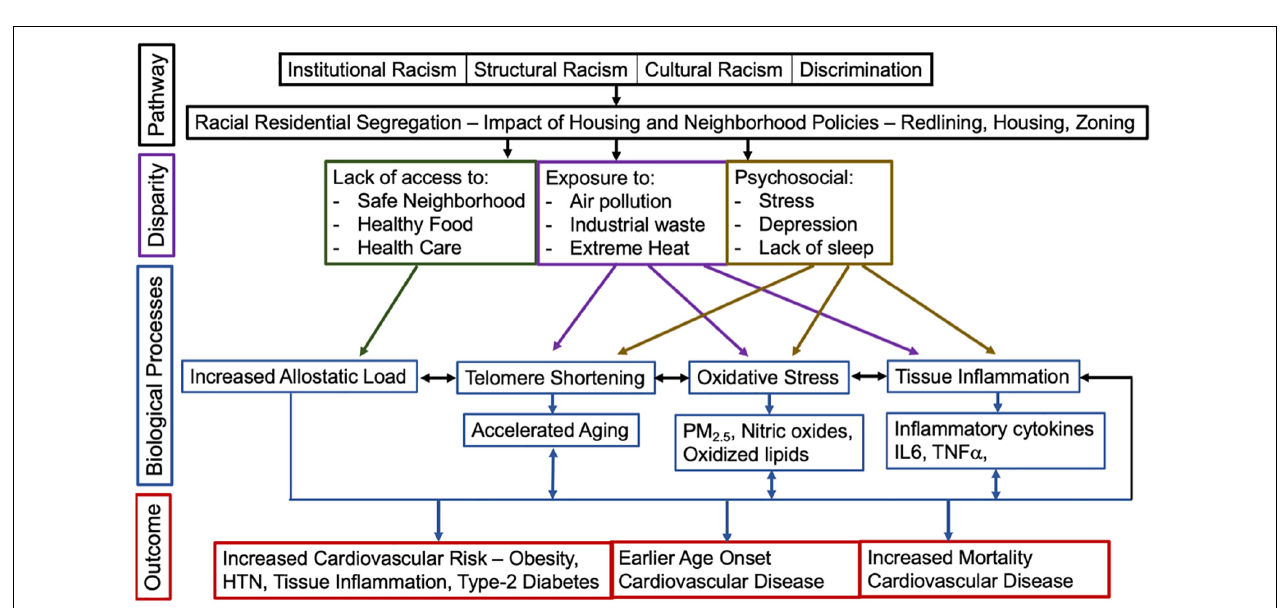
FIGURE 1 | Linking slavery, racism, and discrimination on disparities in the incidence and outcomes cardiovascular disease in Black/African American individuals.